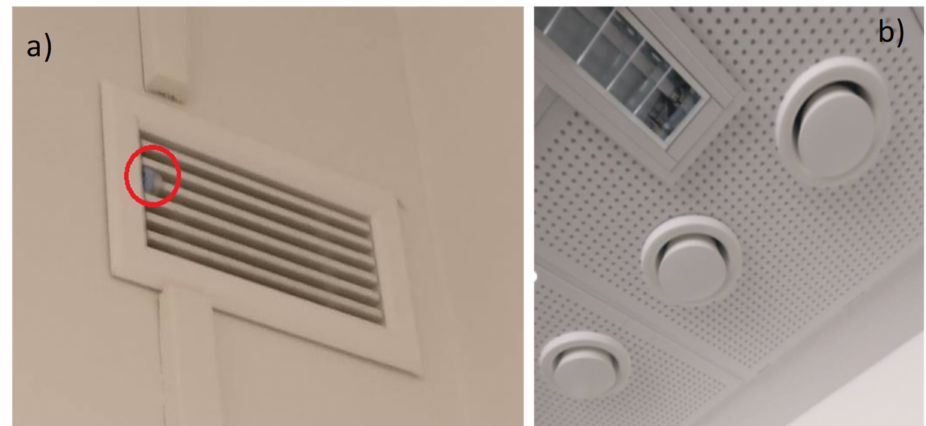
Figure 5. ( a ) Terminal unit with pressure tubes which are folded on the grille for easy measurements and ( b ) airflow horns for units without pressure measurement